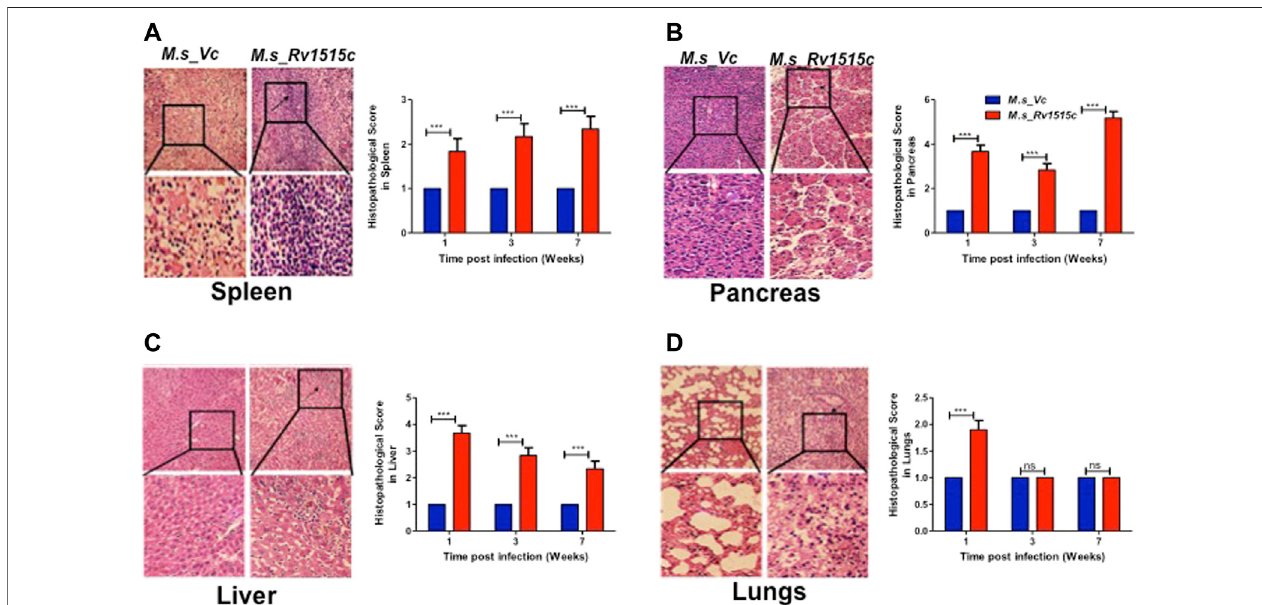
FIGURE 10 | Histopathological analysis of major organs in mice post-infection with M. s_Vc and M. s_Rv1515c . C57BL/6 female mice ( n = 6) were infected intraperitoneally with M. s _Rv1515c and M. s _Vc. Organs were extracted, fi xed and stained with H and E stain, as described in methods. Representative histopathological images (of 1 week post infection) for the various organs at 20X magni fi cation was taken. (A) Spleen- extramedullary haematopoiesis (EMH) and distortedspleenarchitecture(indicatedbyarrow)post-infectionwith M.s _Rv1515c. (B) Pancreas-acinarcellsdestructionandlymphocyticin fi ltration(indicatedby arrows) in pancreas. (C) Liver- lymphocytic in fi ltration and in fl ammation in the liver of mice infected with M. s _Rv1515c. (D) Lungs- mild haemorrhage in alveolar and parenchymalregionoflungat1 week(indicatedbyarrows).Thehistopathologicalparameterswereblindlyscoredonsamplesobtainedat1,3,and7 weeks,andscored as1=Normalhistology,2=Mildchanges,3=Moderatechanges,4=Severechanges,5=Highlyseverechange.Bargraphshowsthehistopathologyscoreasmean± SD and analysed using two-way ANOVA followed by Bonferroni test. *** p < 0.001, ns- nonsigni fi